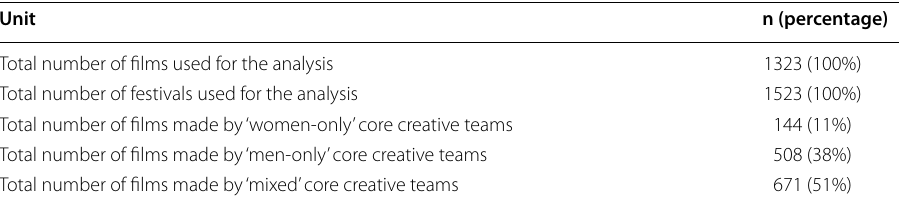
Table 1 Descriptive summary of final sample Unit n (percentage) Total number of films used for the analysis 1323 (100%) Total number of festivals used for the analysis 1523 (100%) Total number of films made by ‘women-only’ core creative teams 144 (11%) Total number of films made by ‘men-only’ core creative teams 508 (38%) Total number of films made by ‘mixed’ core creative teams 671